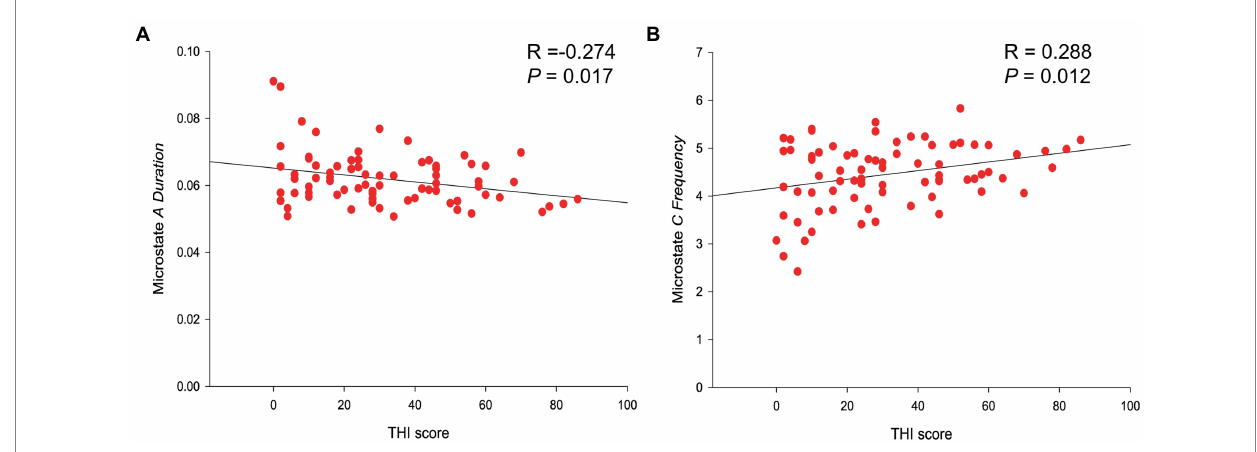
FIGURE 2 Linear regression results of microstate parameters and THI score. (A) THI score was negatively related to the duration of microstates A ( R -value = −0.274; p -value = 0.017). (B) THI score was positively correlated with the frequency of microstate C ( R -value = 0.288; p -value = 0.012).